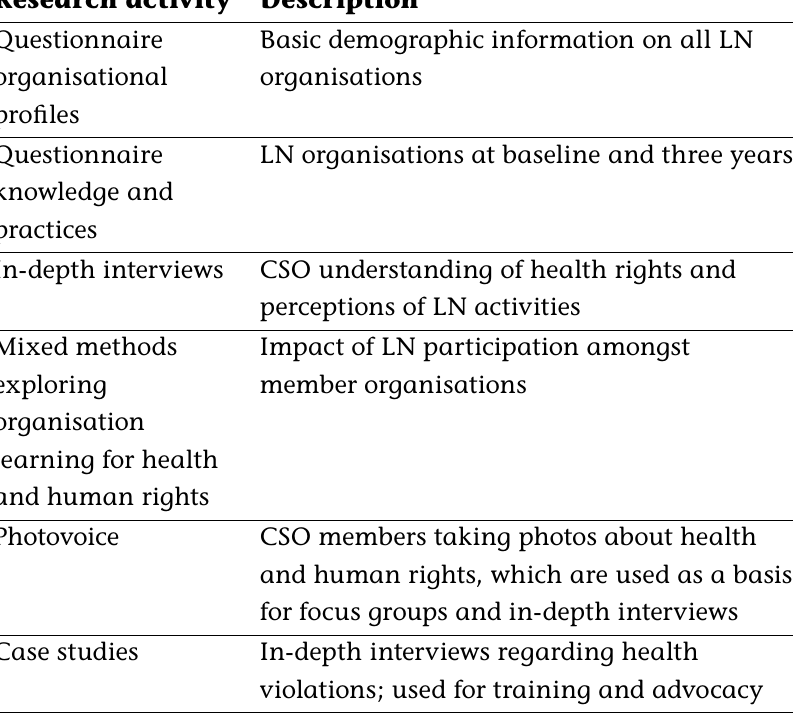
Table 1: Co-research activities undertaken within the LN (adapted from London et al.